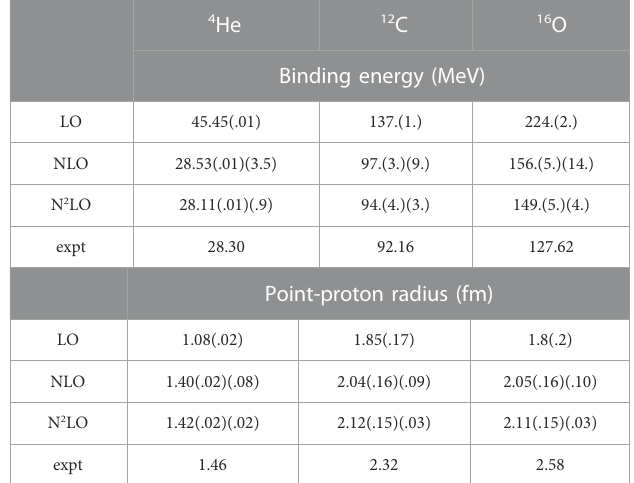
TABLE 1 Ground state binding energies (top) and point-proton RMS radii (bottom) of 4 He, 12 C, and 16 O with LO, NLO, and N 2 LO LENPIC SCS NN potentials. Both our estimated numerical uncertainties ( fi rst set of uncertainties) and chiral truncation uncertainty estimates (second set of uncertainties, not evaluated for LO) are